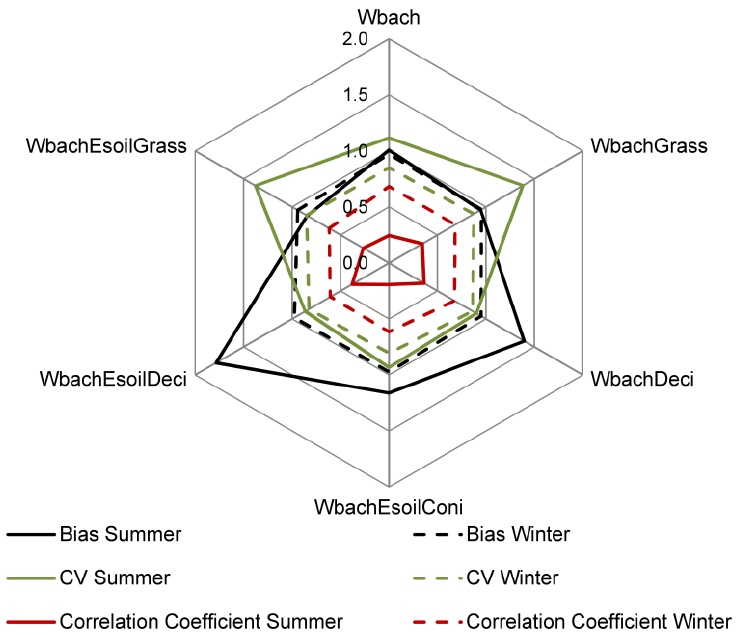
Figure 3. Bias (black line), coefficient of variation (CV; green line) and correlation coefficient (red line) in hydrological summer (solid lines) and winter (dashed lines) for the Wüstebach discharge simulations.